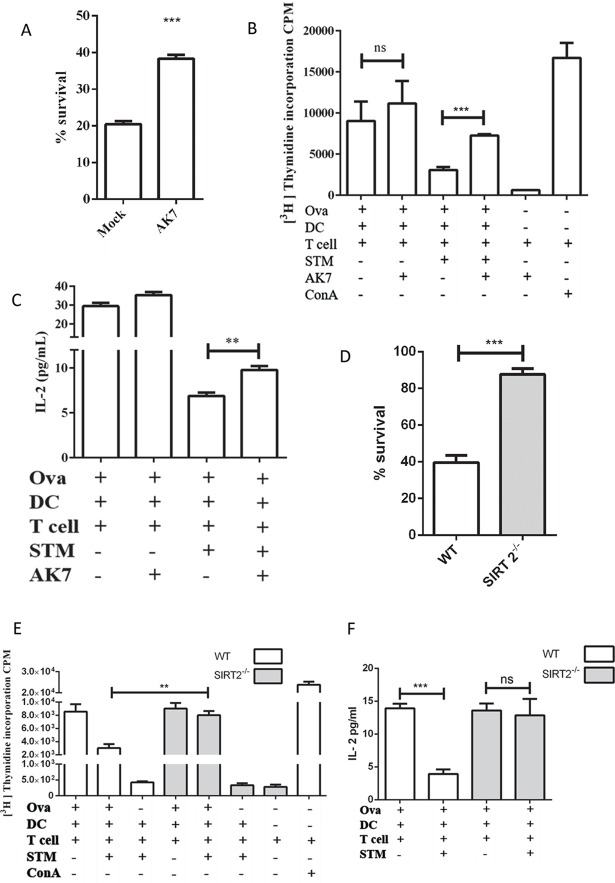
Inhibition of SIRT2 enhances intracellular bacterial survival and CD8+T cell response.A. Percentage survival of intracellular Salmonella in DCs in gentamicin protection assay in the presence and absence of SIRT2 inhibitor, AK7. (Mock- DMSO treated, AK7- 10 μM AK7 treated). (Data are presented as mean ± SEM of 4 independent experiments) B. 3[H] Thymidine incorporation to assess CD8+ T cells proliferation during Salmonella infection in response to SIRT2 inhibition. (Ova- Ovalbumin, DC- Dendritic cells, T cell- mixed lymphocyte, STM- Salmonella Typhimurium, AK7- 10 μM AK7, ConA- Concanavalin A) (Data are presented as mean ± SEM of 3 independent experiments) C. IL-2 levels during CD8+T cells proliferation assay during Salmonella infection in response to SIRT2 inhibition. (Ova- Ovalbumin, DC- Dendritic cells, T cell- mixed lymphocyte, STM- Salmonella Typhimurium) (Data are presented as mean ± SEM of 2 independent experiments) D. Percentage survival of intracellular Salmonella in DCs in gentamicin protection assay in wild type and SIRT-/- DCs. (Data are presented as mean ± SEM of 3 independent experiments) E. 3[H] Thymidine incorporation to assess CD8+ T cells proliferation during Salmonella infection in wild type and SIRT2-/- DCs. (Ova- Ovalbumin, DC- Dendritic cells, T cells- mixed lymphocyte, STM- Salmonella Typhimurium, ConA- Concanavalin A) (Data are presented as mean ± SEM of 3 independent experiments) F. IL-2 levels during CD8+ T cells proliferation assay in response to Salmonella infection in wild type and SIRT2-/- DCs. (Ova- Ovalbumin, DC- Dendritic cells, T cells- mixed lymphocyte, STM- Salmonella Typhimurium) (Data are presented as mean ± SEM of 2 independent experiments) (unpaired two-tailed Student’s t- test, p- value, *** < 0.0001, **<0.001, *<0.01).